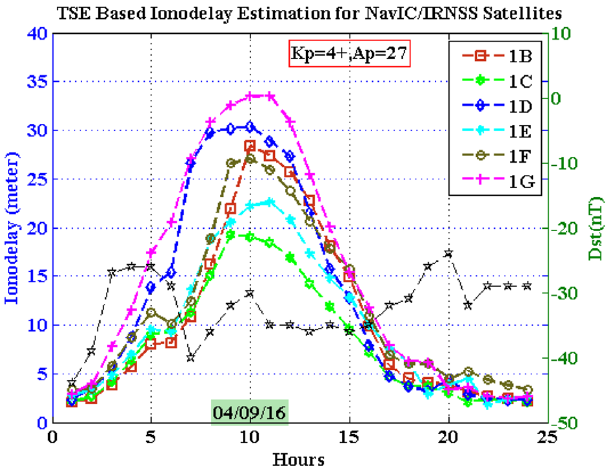
Fig. 15. Ionodelay estimation comparison for NavIC/IRNSS 1G satellites.